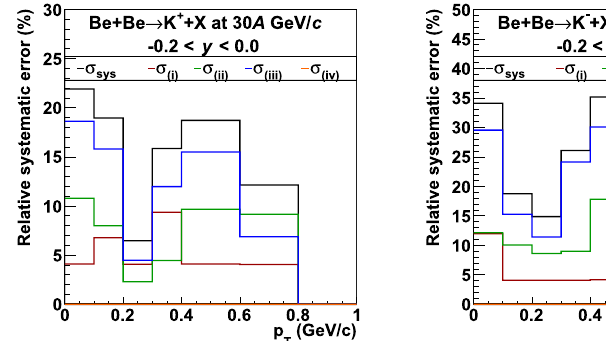
identification technique and σ (iv) (orange lines) to the contamination by feeddown from weak decays of strange particles. Black lines, σ (sys) , show the total systematic uncertainty calculated as the square root of the sum of squares of the